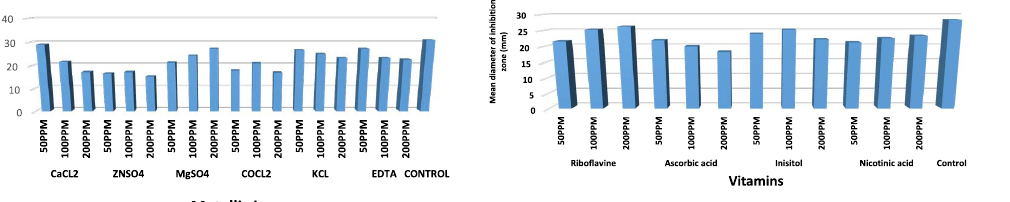
Fig. 2-e. Antimicrobial activity of mixture of ethyl acetate extracts of P. plebeium and E.hirta against MRSA B39 in relation to different metallic ions